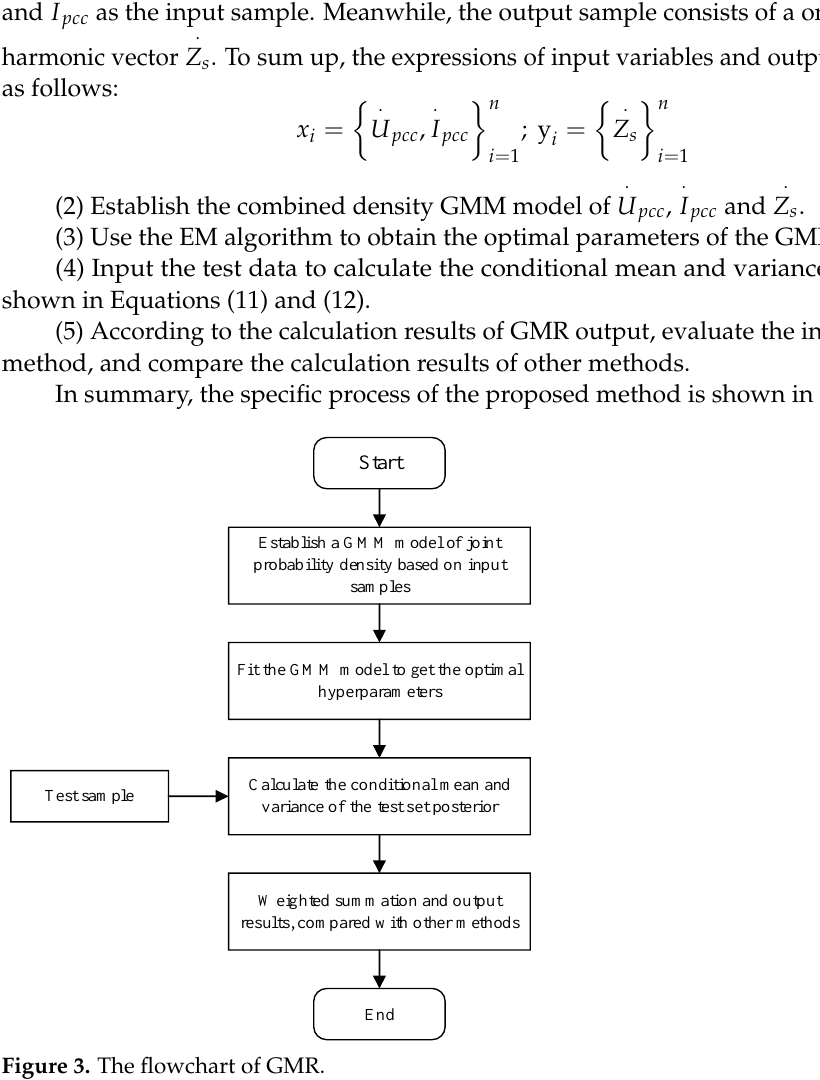
Figure 3. The flowchart of GMR.